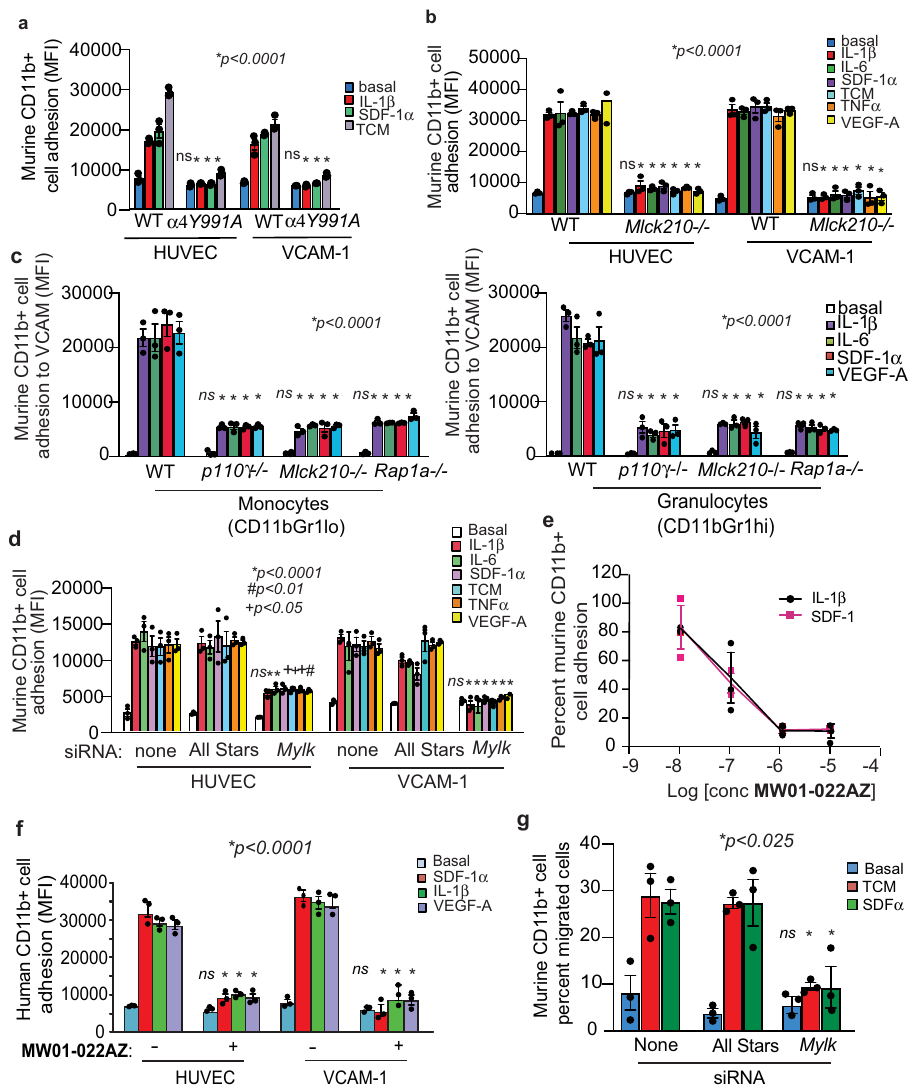
Fig. 2 MLCK210 promotes integrin α 4-mediated myeloid cell adhesion. a Adhesion to HUVEC or VCAM-1, expressed as mean fl uorescence